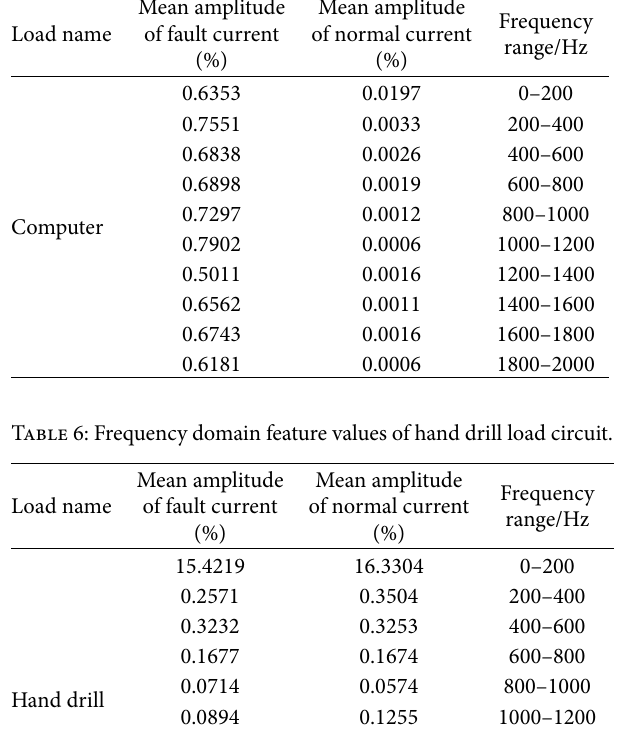
Table 5: Frequency domain feature values of computer load circuit. Load name